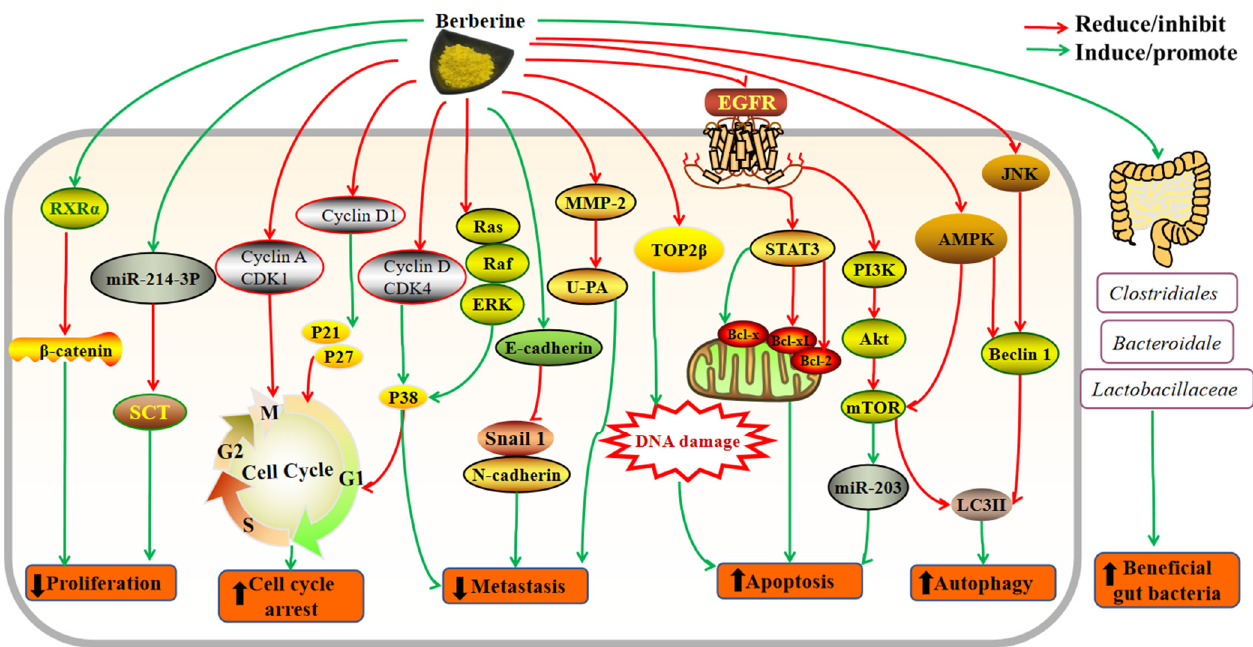
Figure 2. The main effects and mechanisms of berberine on cancers. Berberine could reduce cancer cell proliferation by binding RXR α and subsequently suppressing β -catenin function, upregulating miR-214-3p and reducing SCT; berberine could attenuate cell cycle by inhibiting the levels of CDK1, CDK4, cyclin A, and cyclin D1, and increasing the levels of p21, p27, p38; berberine could inhibit the Ras/Raf/ERK pathway to cause cell cycle arrest and inhibit metastasis; berberine could reduce transcriptional activities of MMP-2 and u-PA to inhibit metastasis; berberine could enhance the levels of E-cadherin, subsequently decrease the level of N-cadherin and snail-1, and ultimately inhibit metastasis; berberine could promote DNA damage through downregulating the level of TOP2 β and then induce apoptosis; berberine could promote apoptosis through activation of STAT3 via inhibiting the phosphorylation of EGFR, increasing the expression of Bcl-x, and downregulating the expression of Bcl-xL and Bcl-2; berberine could induce apoptosis by suppressing the PI3K/AKT/mTOR signaling pathway and upregulating the expression of miR-203; berberine could inhibit the PI3K/Akt/mTOR pathway, and enhance the expressions of LC3B-II to promote autophagy; berberine could induce autophagy via JNK/Beclin1 pathway; berberine could regulate gut microbiota by increasing beneficial gut bacteria Clostridiales , Bacteroidale , and Lactobacillaceae . Abbreviations: Akt, protein kinase B; Bcl-2, B-cell lymphoma 2; CDK, cyclin-dependent kinase; EGFR, epidermal growth factor receptor; JNK, c-Jun N-terminal kinase; LC3, microtubule-associated protein light chain 3; mTOR, mammalian target of rapamycin; MMP-2, matrix metalloproteinase 2; PI3K, phosphatidylinositol-3-kinase; RXR α , retinoid X receptor α ; SCT, secretin; STAT3, transcription 3; TOP2 β , Topoisomerase II β ; u-PA, urokinase-type plasminogen